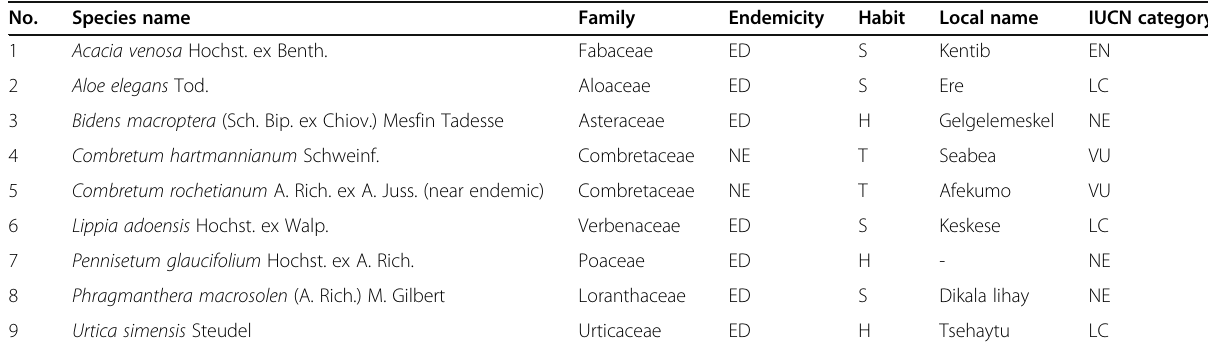
Table 1 Endemic species and their IUCN status ( ED endemic, NE near-endemic, H herb, S shrub, T tree, LC least concern, EN endangered, NE not evaluated, VU